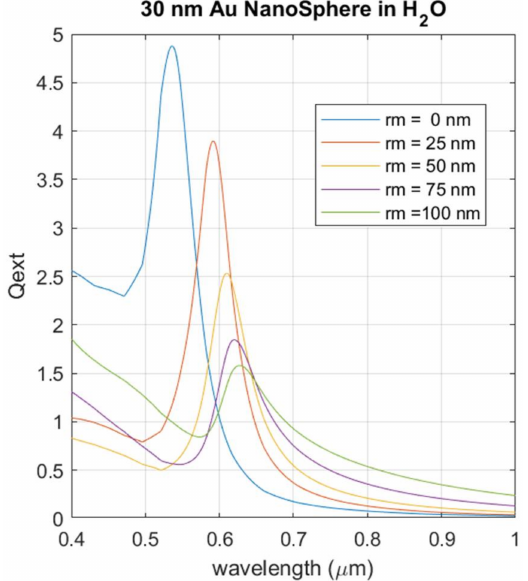
Figure 10. Simulated LSPR intensity for AuNPs with fixed dimensions (radius 30 nm). Gold nanospheres are immersed in pure water and have a capping layer of EGCG with thickness between 0 and 100